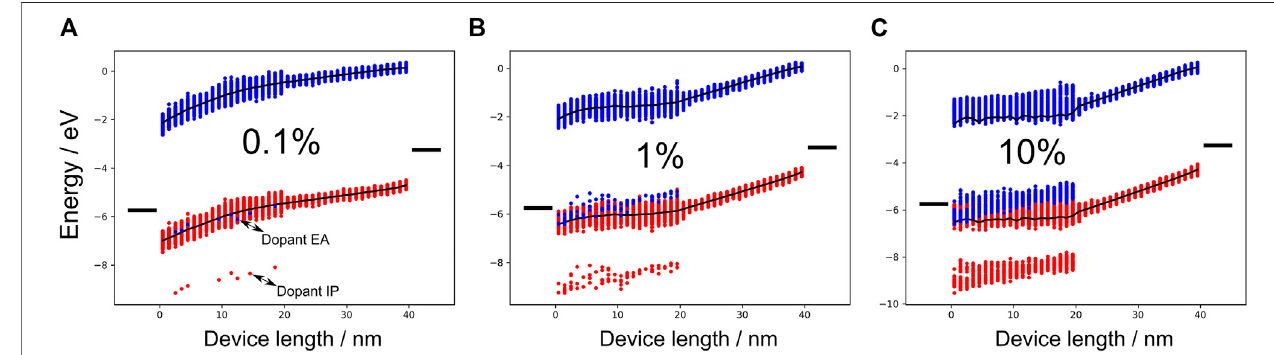
FIGURE4| Energydiagramsofthetestdeviceforconductivitysimulations.TheblackbarsontheleftofeachpanelrepresentstheFermileveloftheelectrodes.The red and blue dots illustrate the IP and EA, respectively. With a doping concentration of 0.1% (A) , the majority of red (blue) dots represent the host IPs (EAs). The dopant IPs and EAs are explicitly annotated. At such small doping concentrations, no Fermi level alignment is achieved. With a doping concentration of 1% (B) , the injection barrier is signi fi cantly smaller compared to the low doping case. Fermi level alignment is accomplished at a large doping concentration of 10% (C) .